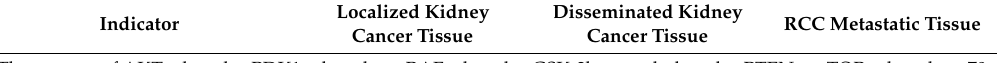
Table 4. The content and mRNA level of AKT, phospho-PDK1, phospho-c-RAF, phospho-GSK-3beta, phospho-PTEN, m-TOR, phospho-p70 S6 kinase and phospho-4E-BP1 in patients with localized and disseminated kidney cancer, as well as in metastatic